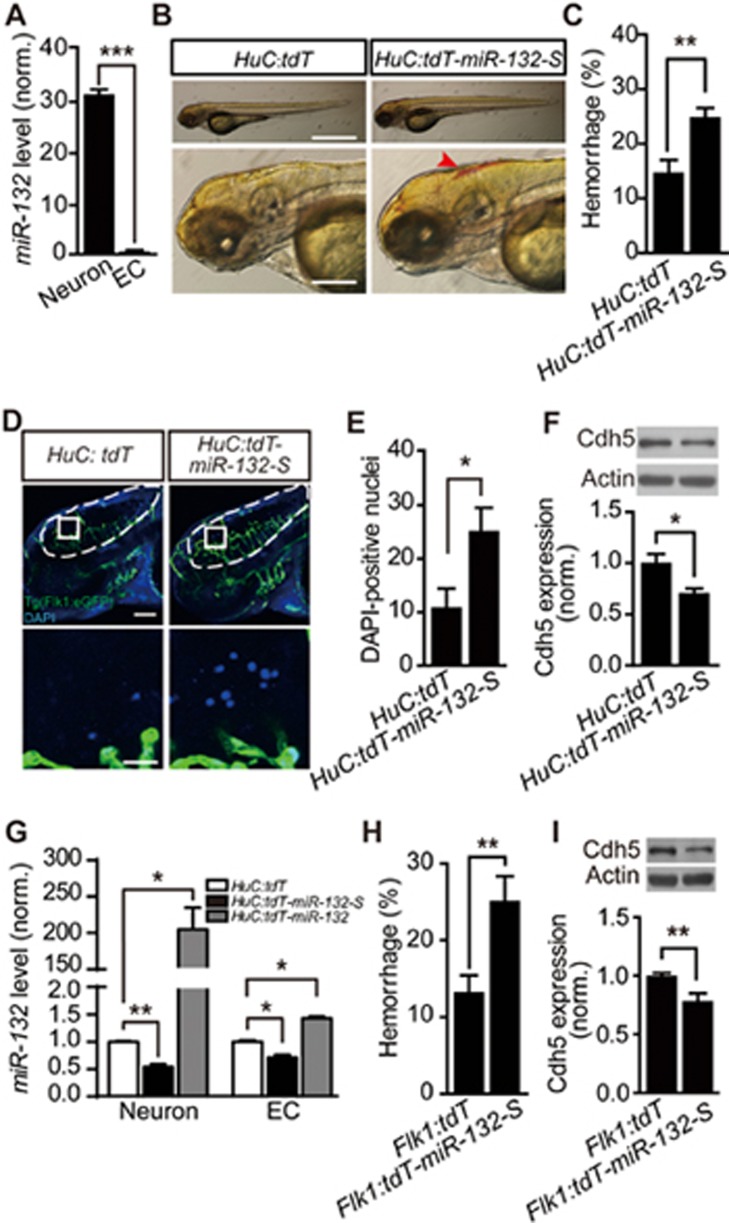
Neuronal miR-132 regulates brain vascular integrity by affecting endothelial miR-132 level. (A) Relative expression level of miR-132 in zebrafish neurons and ECs, which were sorted by flow cytometry from 3-dpf Tg(HuC:GFP) or Tg(Flk1:eGFP) larvae, respectively. The experiments were repeated three times. (B-F) Effects of miR-132 sponge (miR-132-S)-mediated neuron-specific miR-132 downregulation on intracranial hemorrhage (B, C), DAPI leakage (D, E), and Cdh5 expression (F) in zebrafish larvae. The sponge was inserted into the tdTomato (tdT) 3′ UTR and driven by the HuC promoter (“HuC:tdT-miR-132-S”). Expression of tdT in neurons (“HuC:tdT”) served as a control. The experiments were repeated 10 times in C and 5 times in F, and 11 embryos injected with HuC:tdT and 8 embryos injected with HuC:tdT-miR-132-S were analyzed in E. (G) Coordinated changes of miR-132 level in zebrafish neurons and ECs, both of which were sorted from 3-dpf Tg(Flk1:eGFP) larvae transiently expressing HuC:tdT, HuC:tdT-miR-132-S or HuC:tdT-miR-132. Expression of HuC:tdT-miR-132-S or HuC:tdT-miR-132 was used to down- or upregulate miR-132 level in zebrafish neurons, respectively. The experiments were repeated 3-4 times. (H,I) Effects of miR-132-S expression in ECs on intracranial hemorrhage (H) and Cdh5 expression (I) in zebrafish larvae. The experiments were repeated nine times in H and six times in I. For each time, > 14 embryos were examined for each group in H. Scale bar, 400 μm (top) and 100 μm (bottom) (B), 100 μm (top) and 20 μm (bottom) (D). Error bars, SEM. *P < 0.05, **P < 0.01, ***P < 0.001 (unpaired two-tailed Student's t-test for A, C, E, F, H and I; one-way ANOVA with post hoc Bonferroni's multiple comparison test for G).